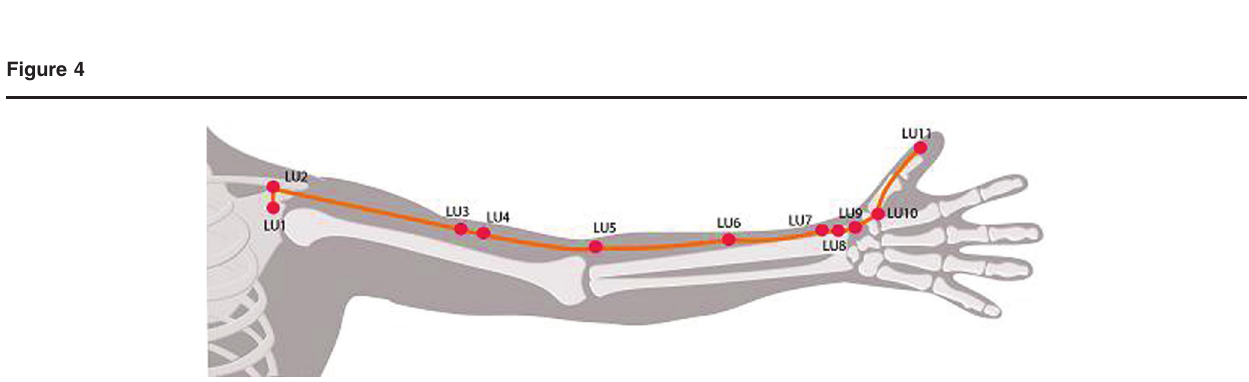
Lung meridians. Image courtesy of